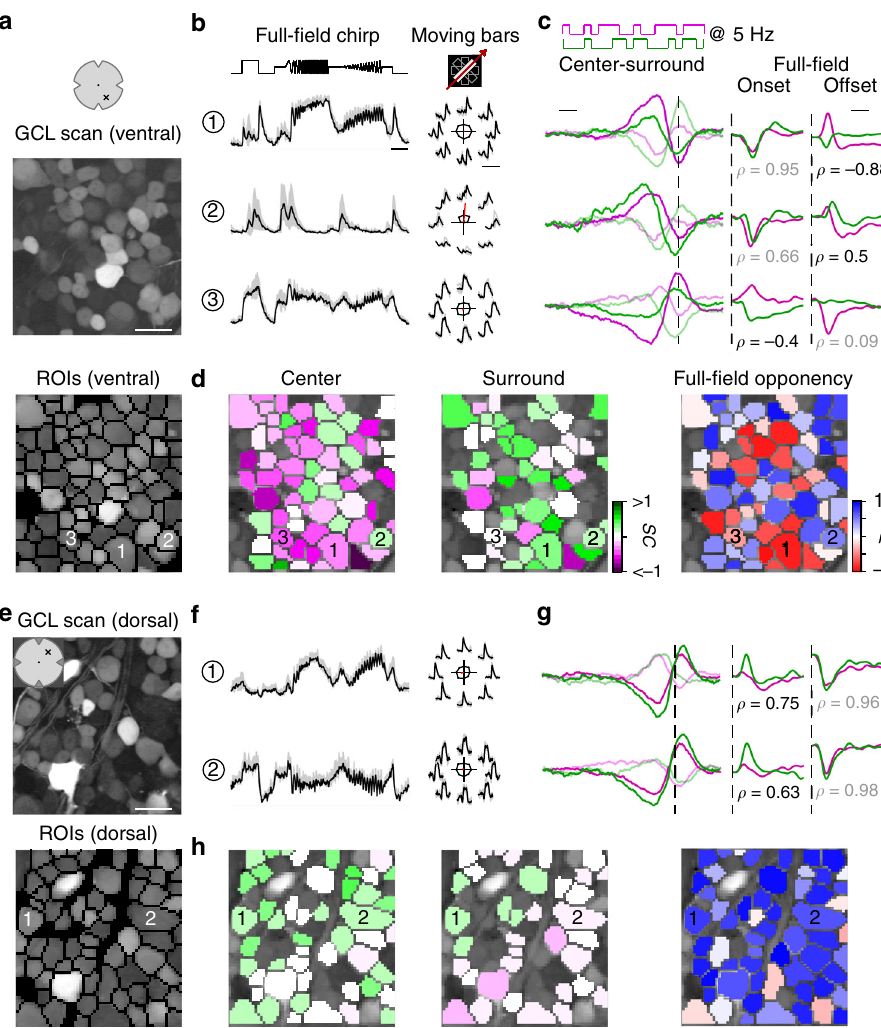
Fig. 5 Chromatic responses in the ganglion cell layer of the mouse retina. a Ganglion cell layer (GCL) scan fi eld (top; 95 × 95 µ m, 7.8125 Hz) located in the ventral retina electroporated with the synthetic calcium indicator Oregon – Green BAPTA-1 (OGB-1) and corresponding ROI mask (bottom). Scale bar: 20 µ m. b Mean calcium traces (black, s.d. shading in gray; n = 5 trials) of ROIs indicated in ( a , bottom) in response to full- fi eld chirp (left, scale bar: 3 s) and moving bars (right, scale bar: 4 s). c Temporal center (bright) and surround (dim) kernels estimated from a 5 Hz center-surround fl icker stimulus of UV and green LED (left, scale bar: 200 ms) and mean calcium events in response to onset and offset of a full- fi eld UV and green stimulus (right, scale bar: 0.2 s) for ROIs indicated in ( a , bottom). Linear correlation coef fi cient of full- fi eld events indicated below traces. For further analysis, min( ρ onset , ρ offset ) indicated in black is considered as full- fi eld opponency (Methods). Dotted lines indicate time point of response/stimulus. d ROIs from ( a , bottom) color-coded according to center (left) and surround spectral contrast (SC; middle) as well as full- fi eld opponency (right). e Scan fi eld and corresponding ROI mask located in the dorsal retina. Scale bar: 20 µ m. f – h Like b – d , but for scan fi eld shown in e . Scan fi elds/traces shown in this fi gure correspond to representative examples. In total, we recorded n = 100 scan fi elds in n = 20 mice. For quanti fi cation, see Figs. 6,